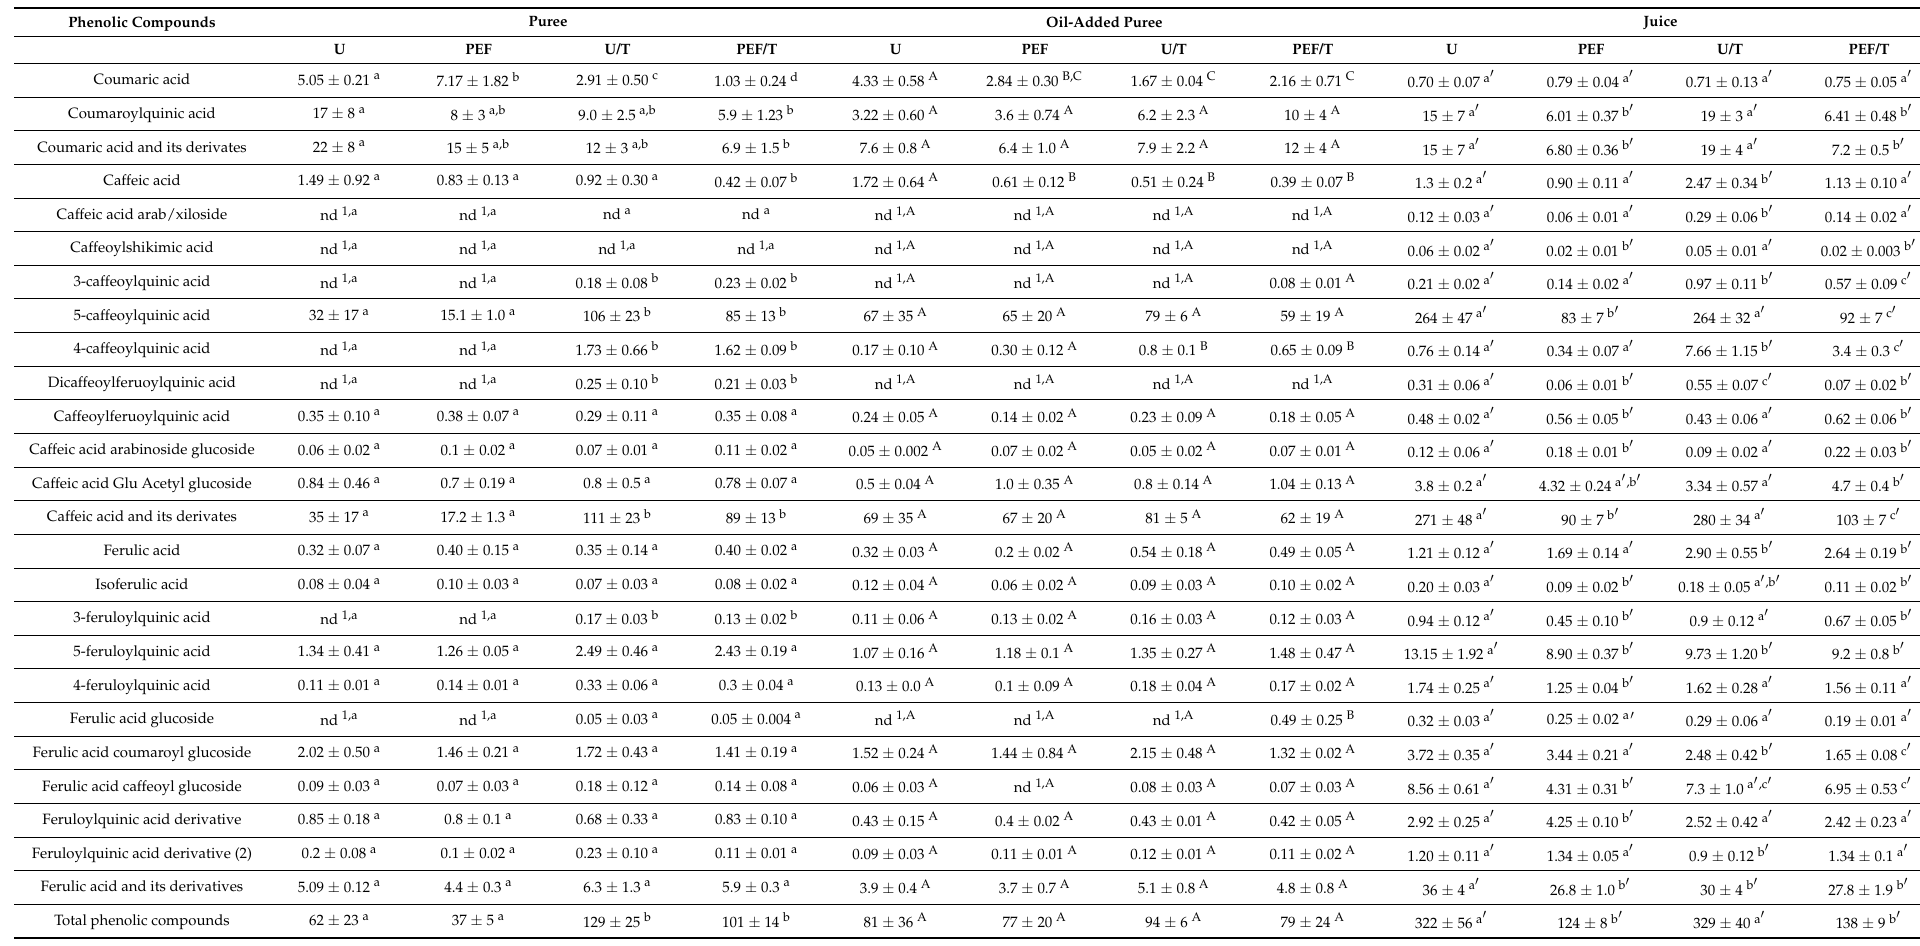
Table 3. Phenolic content in untreated purees and juices (U), those obtained from PEF-treated (0.61 kJ kg − 1 ) carrots (PEF), and those thermally treated (10 min at 70 ◦ C) (U/T and PEF/T).